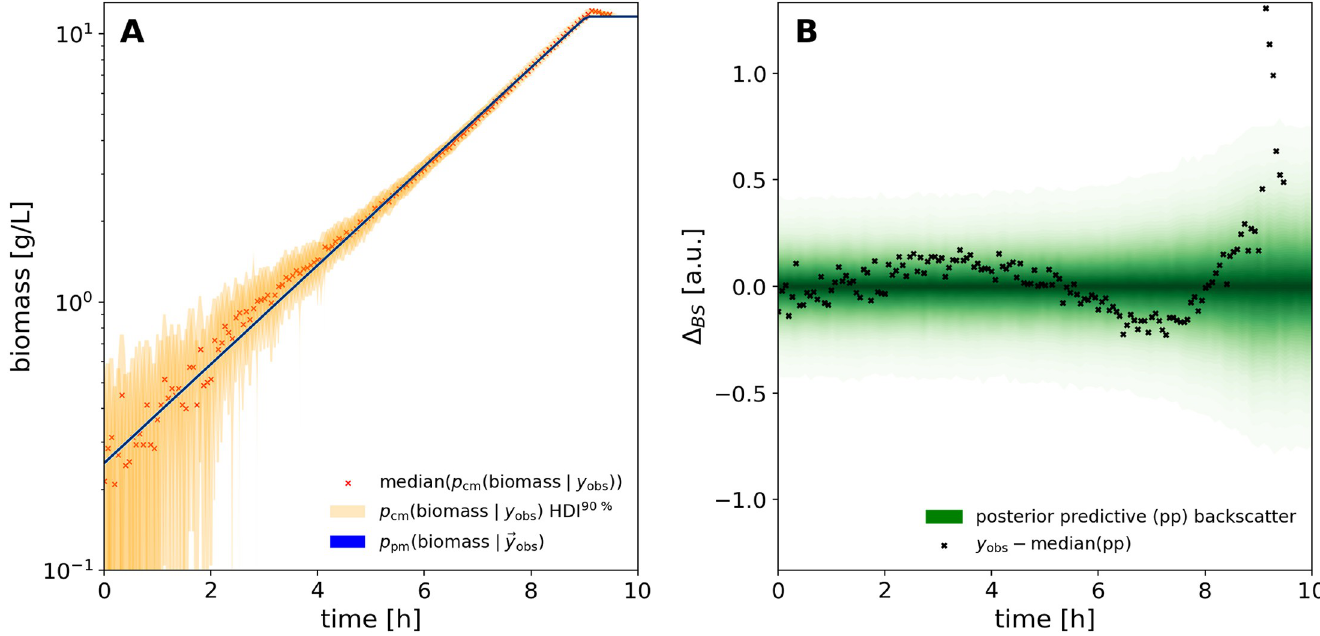
Fig 14. Predictions, observations and residuals of Monod model fitted to backscatter data. A : Through a logarithmic y-axis, the plot A shows that both process model (blue density) and the HDI 90 % obtained from the biomass calibation model with individual observations (orange) describe an exponentially increasing biomass biomass concentration up to approximately 9 hours. B : The residuals between prediction and observed backscatter (black) and the posterior predictive backscatter distribution (green density) show that the lack-of-fit is consistently less than ± 0.25 backscatter units with the exception of a fluctuation at the time of substrate depletion.